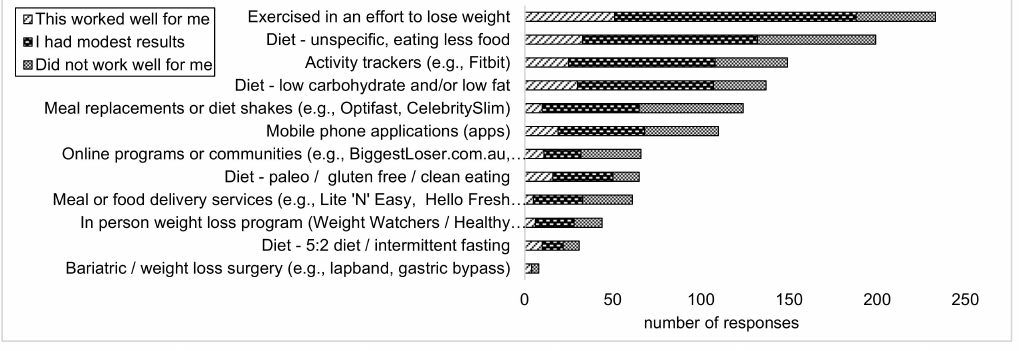
Figure 3. Diet strategies tried and how well they